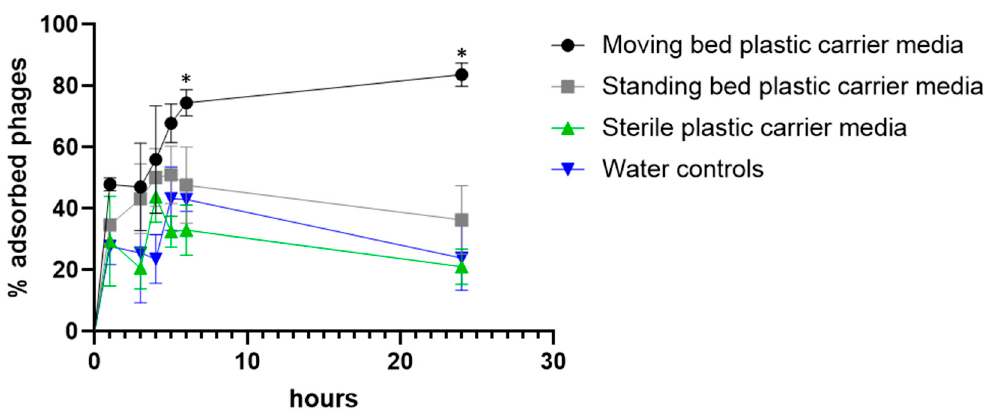
Figure 2. Adsorption of phage to plastic carrier media. Each condition was tested in triplicates. Unpaired t-tests were used for comparing the controls and tested conditions. * Statistical difference found (exact p values are mentioned in the text).